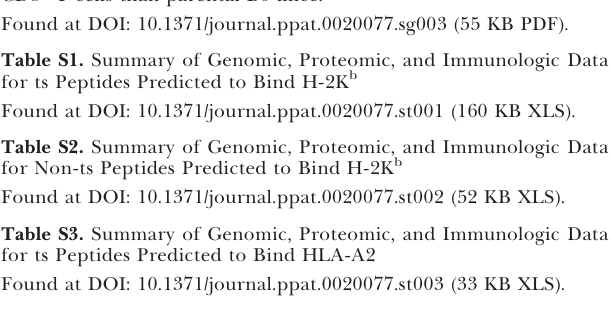
Table S1. Summary of Genomic, Proteomic, and Immunologic Data for ts Peptides Predicted to Bind H-2K b Found at DOI: 10.1371/journal.ppat.0020077.st001 (160 KB XLS). Table S2. Summary of Genomic, Proteomic, and Immunologic Data for Non-ts Peptides Predicted to Bind H-2K b Found at DOI: 10.1371/journal.ppat.0020077.st002 (52 KB XLS). Table S3. Summary of Genomic, Proteomic, and Immunologic Data for ts Peptides Predicted to Bind HLA-A2 Found at DOI: 10.1371/journal.ppat.0020077.st003 (33 KB